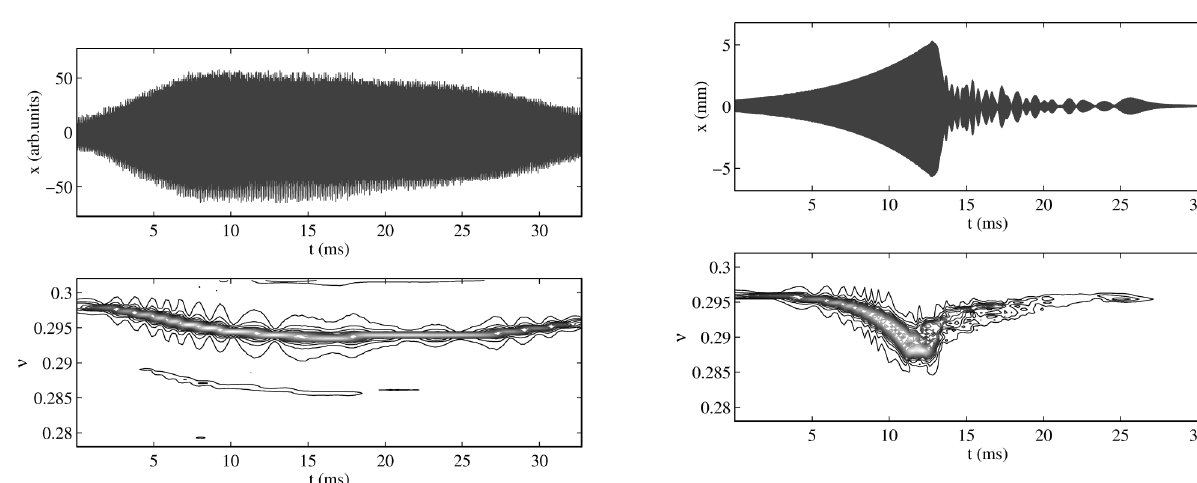
FIG. 8. Simulation of the horizontal instability for K 2 : 3 m (cid:6) 2 .